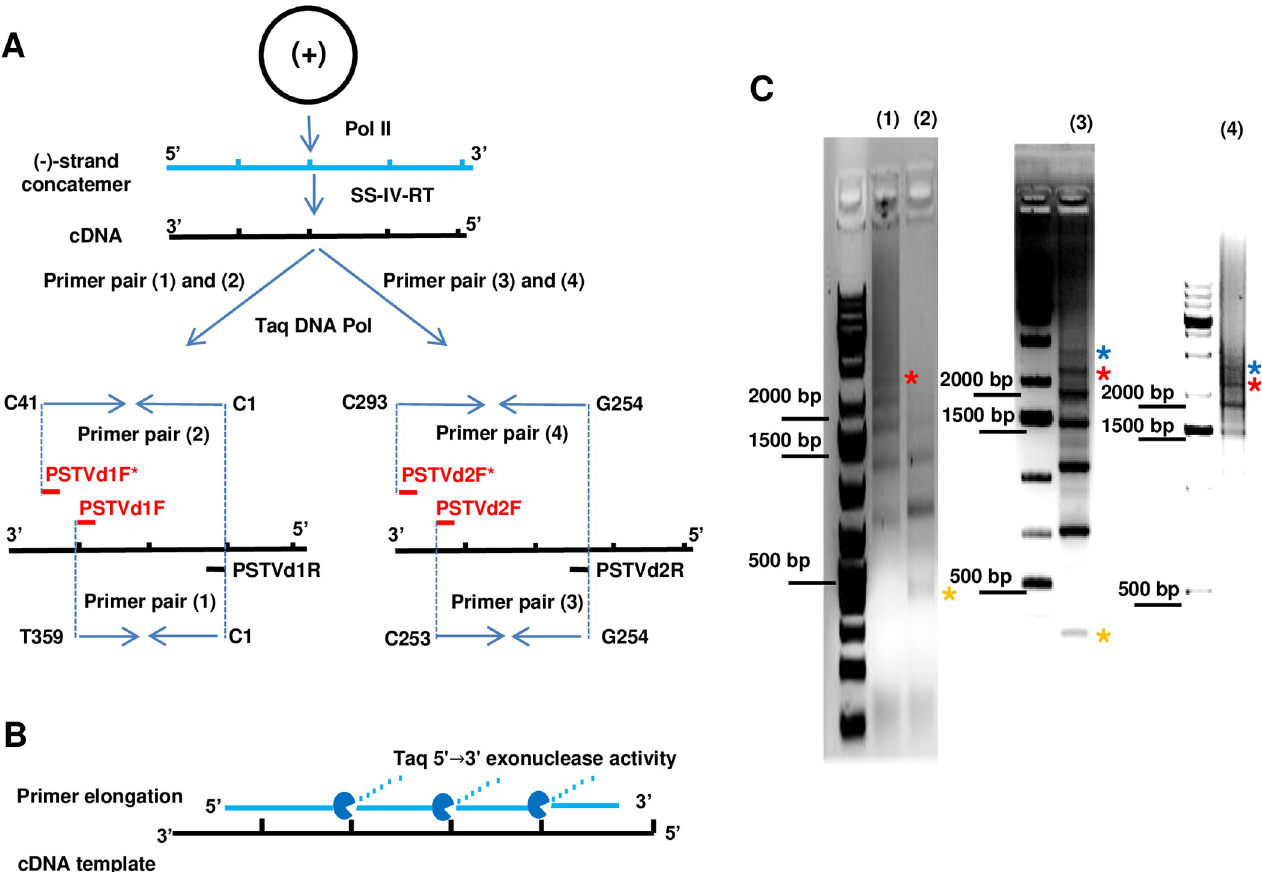
Fig 2. PCR amplification of (-)-strand PSTVd concatemers. (A) Schematic diagram shows transcription of (+)-strand PSTVd monomer by Pol II to synthesize linear (-)-strand concatemer, followed by cDNA synthesis from (-)-strand RNA using Superscript IV reverse transcriptase (SS-IV-RT). Taq DNA polymerase was employed to perform PCR amplification of duplex DNA copies from the cDNA using four separate primer pairs, as shown. The nucleotide coordinates of forward (F) and reverse (R) primers are indicated. Primers can bind to the same sites in all monomers, but for simplification only one binding site is indicated for each. PCR reactions (1) and (3) yield products with primers included in the concatemers, while reactions (2) and (4) yield products with concatemers flanked by primers (indicated by an asterisk). (B) With 5’ ! 3’ exonuclease activity, Taq DNA polymerase is able to synthesize through downstream products (nick translation). (C) PCR products amplified by Taq DNA Polymerase using primer sets 1 through 4 were resolved by 1% agarose gel electrophoresis. Ladders of discrete products correspond to genome concatemers. Monomer, hexamer, and heptamer products are indicated by asterisks (yellow, red, and blue,